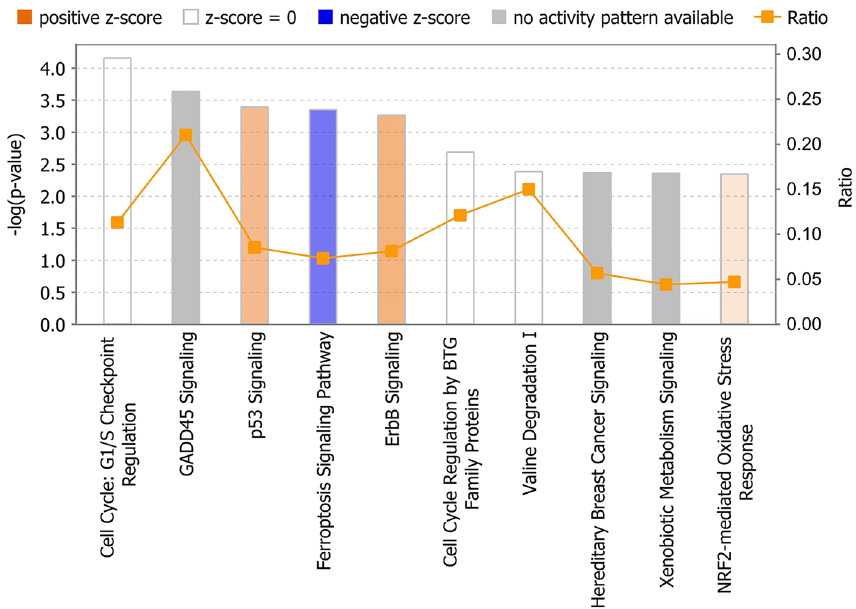
Figure 3. IPA top 10 canonical pathways for the common DEGs. Canonical pathways were sorted by − log( p - value). A positive z -score (orange) denotes pathway activation, and a negative z -score (blue) denotes pathway inhibition. Ratio refers to the percentage of DEGs among the total number of genes that make up the pathway.